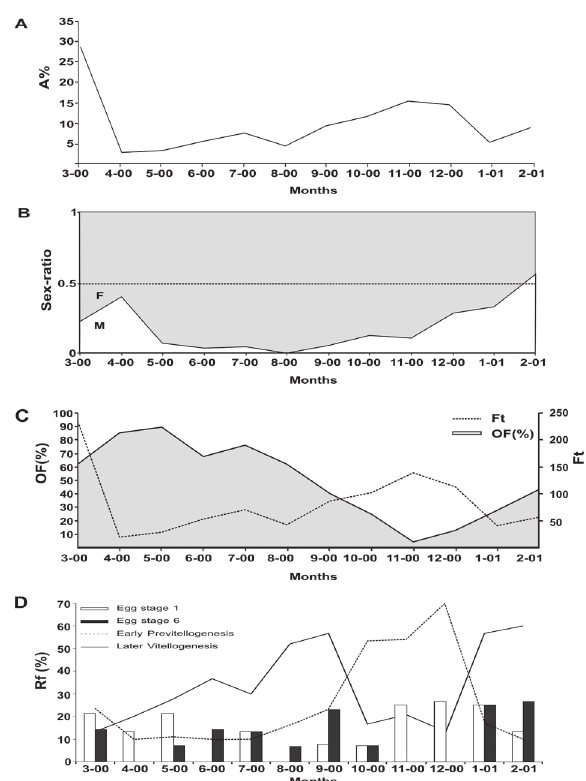
Fig . 3. – a. Monthly relative abundance (a%) throughout the cycle. b. Changes in sex-ratio. C. Monthly evolution of the frequency of ovigerous females (oF (%)) and total females (Ft). D. Monthly evo- lution of gonad maturation and egg stages 1 (white) and 6 (black) of embryo development. rf (%): relative